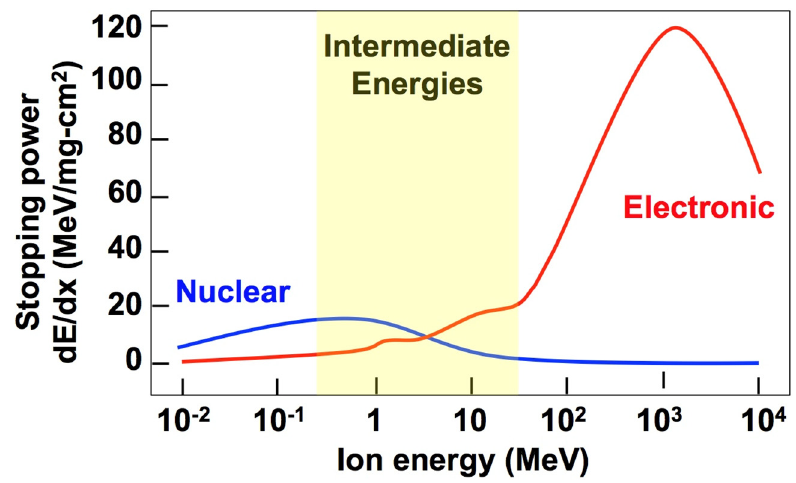
Figure 1. Illustration of three relevant regimes of stopping power, where electronic energy losses are dominant at high irradiating particle energies, nuclear energy losses are dominant at low energies, and both electronic and nuclear energy losses contribute at intermediate energies.